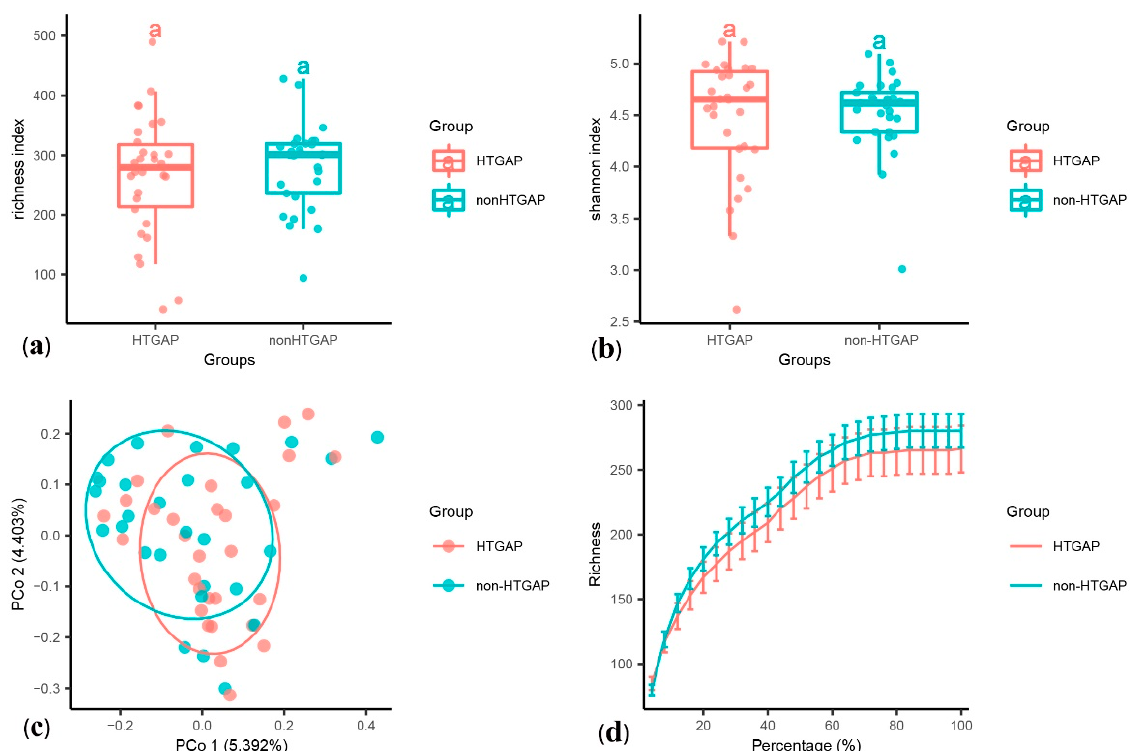
Figure 1. Alpha and beta diversity analysis between HTGAP and non-HTGAP groups. ( a ) Alpha diversity based on species richness. ( b ) Alpha diversity based on Shannon’s diversity index. Box-plot features represent the median (central line), upper and lower quartiles (box), and the maximum and minimum values of the data (bars). ( c ) Beta diversity analysis based on PCoA plot. The abscissa and ordinate represent the contribution rate of the first principal component (5.392%) and the second principal component (4.403%) to the sample difference. Each symbol represents the gut microbiota of a sample. ( d ) Rarefaction curve of species richness. HTGAP, hypertriglyceridemia-associated acute pancreatitis; PCoA, principal coordinate analysis.